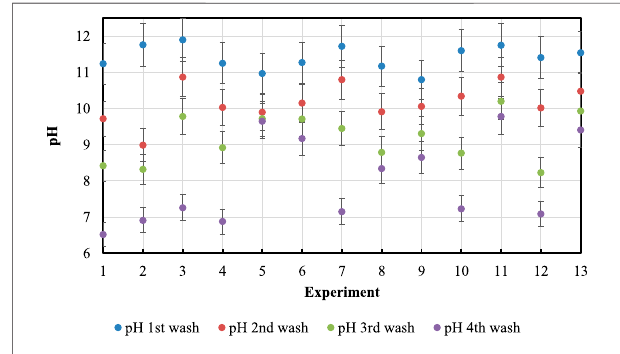
FIGURE 1 | pH of wash water as base to estimate alkali